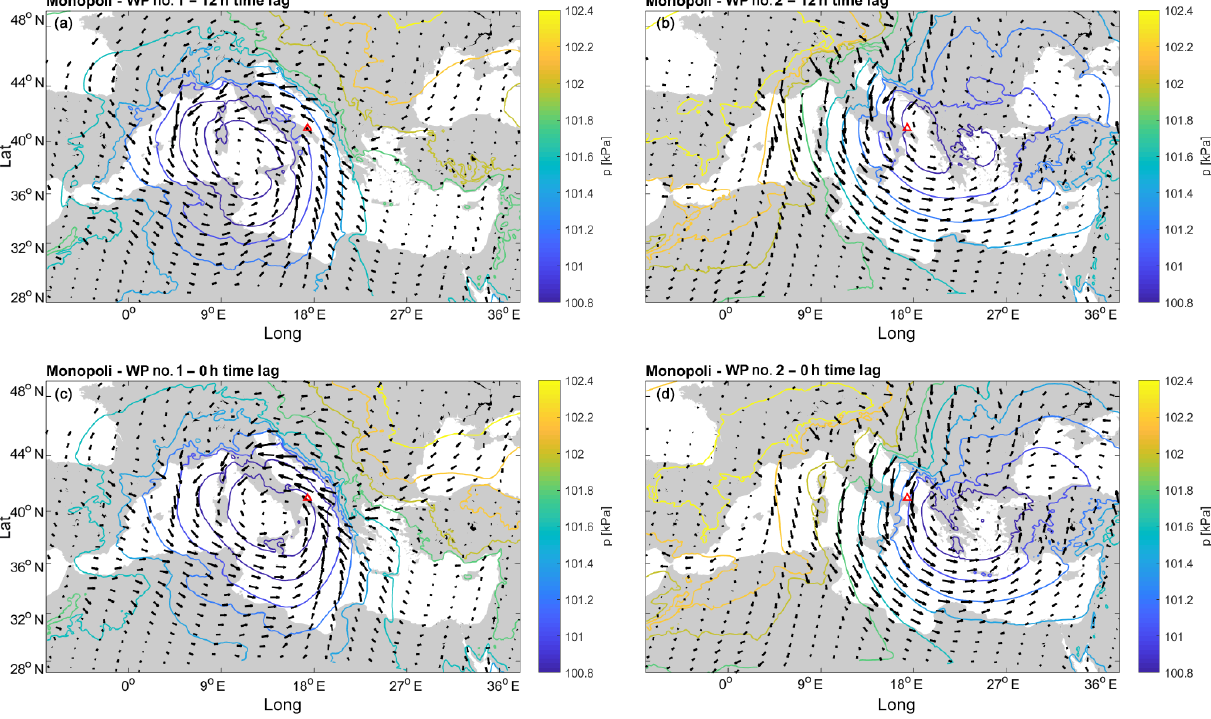
Figure 4. Average MSLP for the H s peaks in Monopoli (B7). (a) WP#1, (cid:49)t equals 12h; (b) WP#2, (cid:49)t equals 12h; (c) WP#1, (cid:49)t equals 0h; (d) WP#2, and (cid:49)t equals